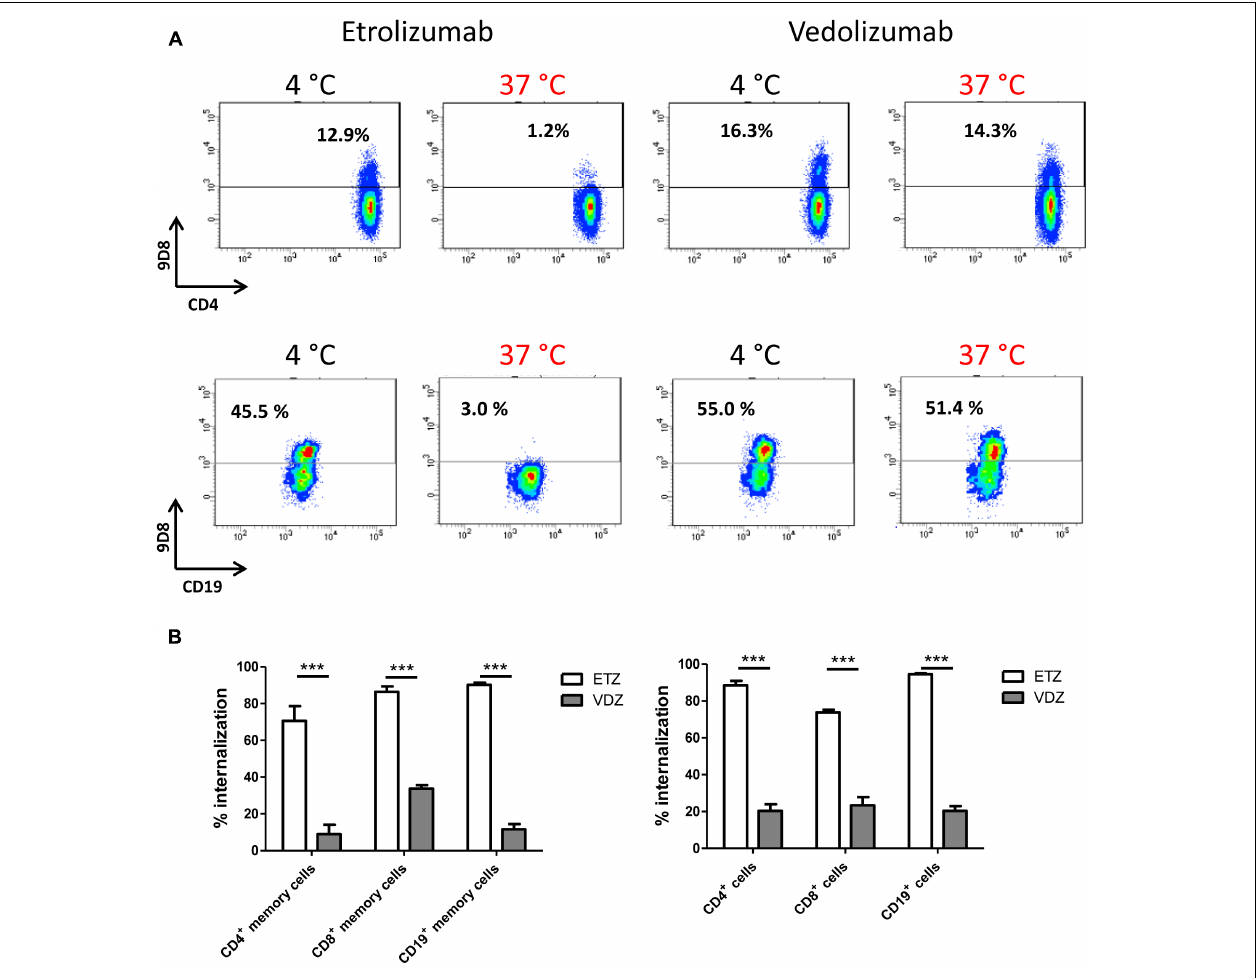
FIGURE 9 | Comparison of β 7 internalization after treatment with vedolizumab and etrolizumab in vitro . (A) Internalization of β 7 on CD4 + T and CD19 + B cells from the peripheral blood of human donors. Representative dot plots indicating the percentage of β 7 + cells upon treatment with etrolizumab or vedolizumab at 4 or 37 ◦ C as indicated. (B) Quantification of β 7 + internalization (decrease of surface β 7 expression related to expression observed after treatment at 4 ◦ C) in T and B cell subsets treated with etrolizumab or vedolizumab as indicated. Memory cells were defined as CD45RA − . All analyses were performed on β 7 high cells ( n = 5 donors). ETZ, etrolizumab; VDZ, vedolizumab; n = 10. ∗∗∗ p <